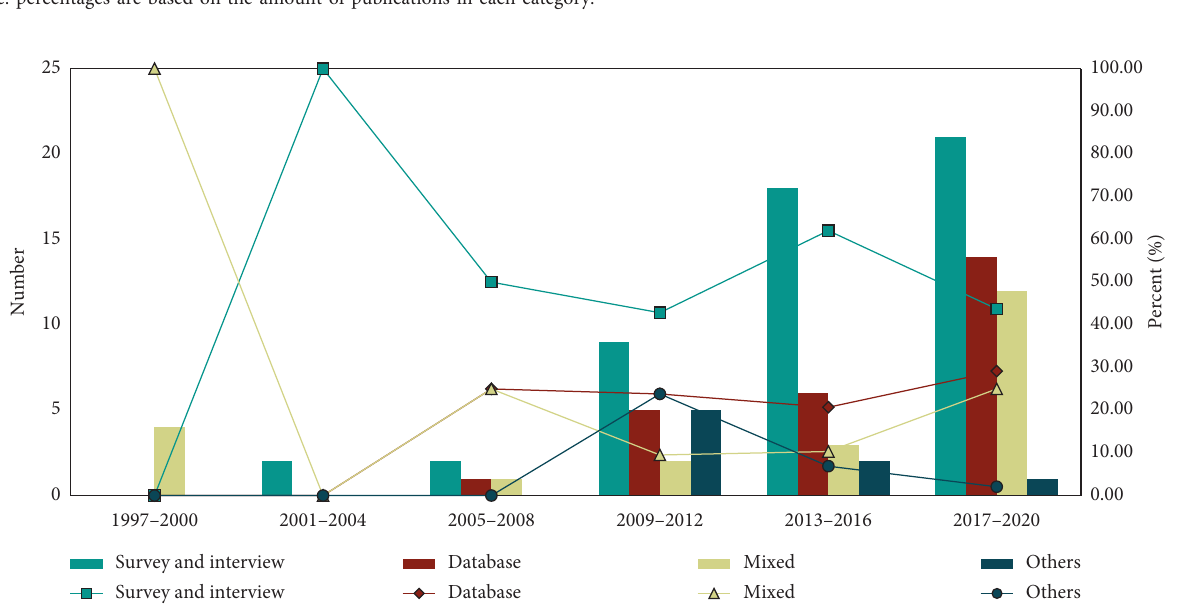
Figure 6: Trends in data sources across years